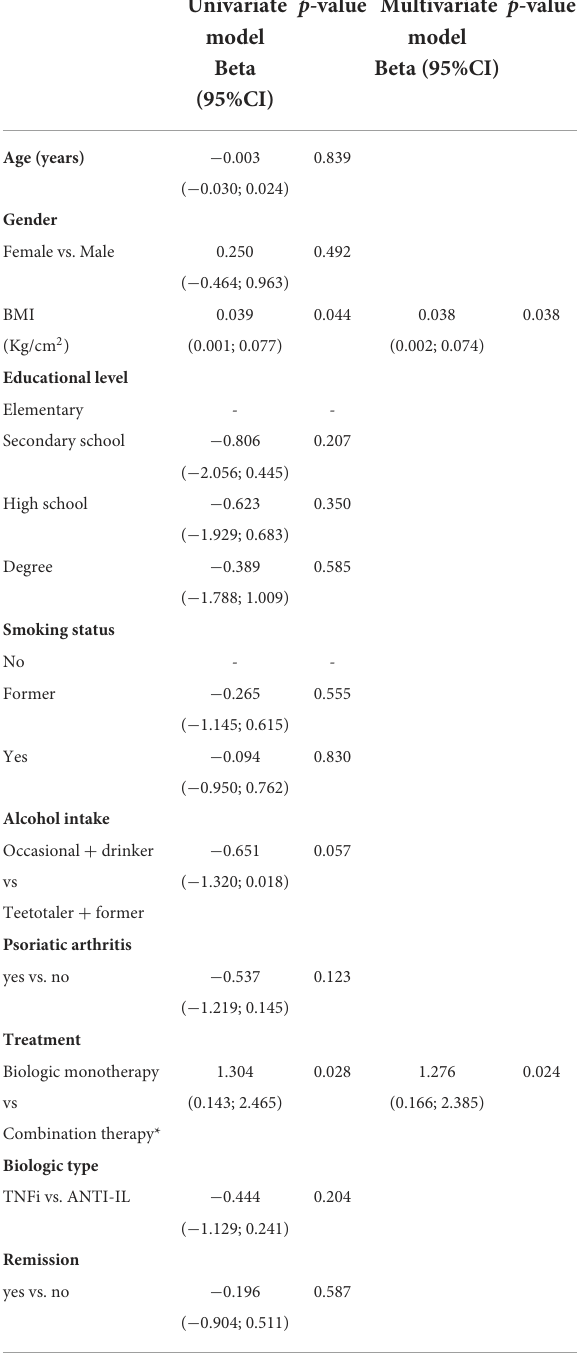
TABLE 4 Generalized linear model (GLM) of IgG at TP4 (4 weeks post 3rd dose) in psoriasis